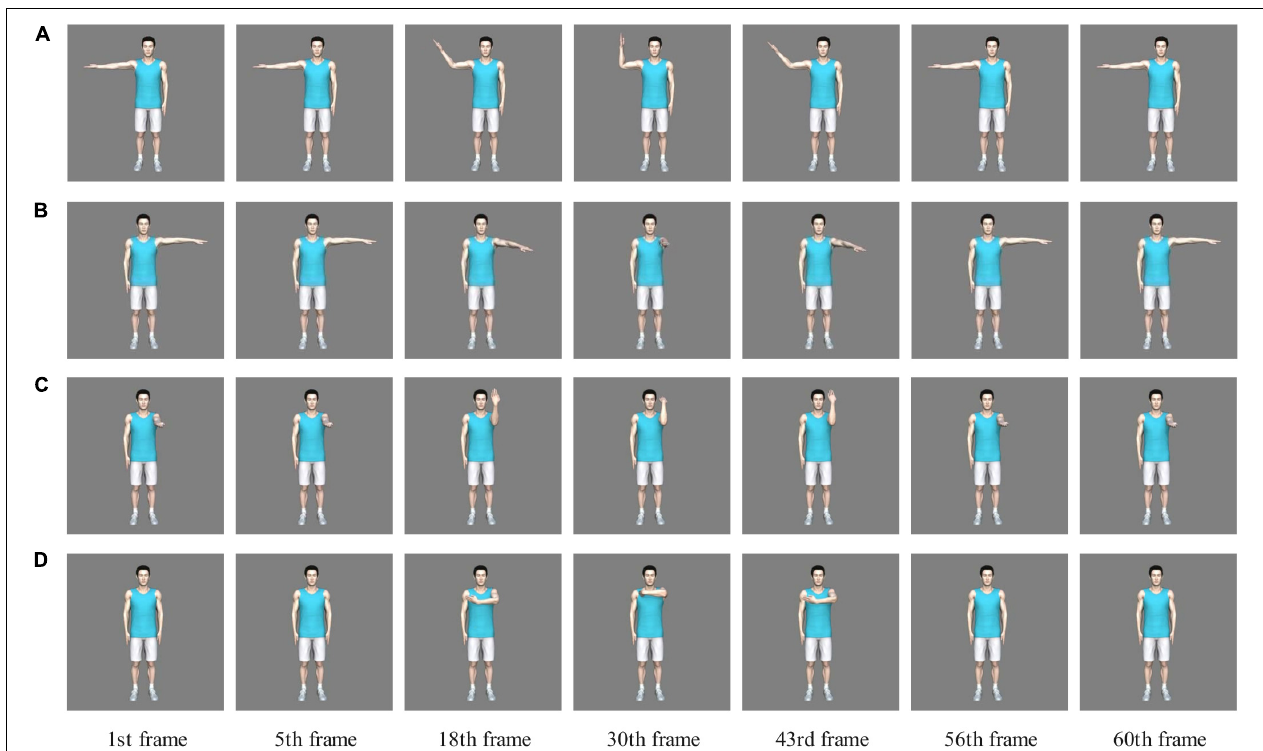
FIGURE 1 | Part of the computer generalized motion animations. (A) A flexion-extension motion of the right upper limb’s elbow joint in the frontal plane. (B) An adduction-abduction motion of the left upper limb’s shoulder joint in the horizontal plane. (C) A flexion-extension motion of the left upper limb’s wrist and elbow joint in the sagittal plane. (D) A complex motion containing flexion-extension motion of the left upper limb’s wrist, elbow, and shoulder joint in the sagittal and horizontal